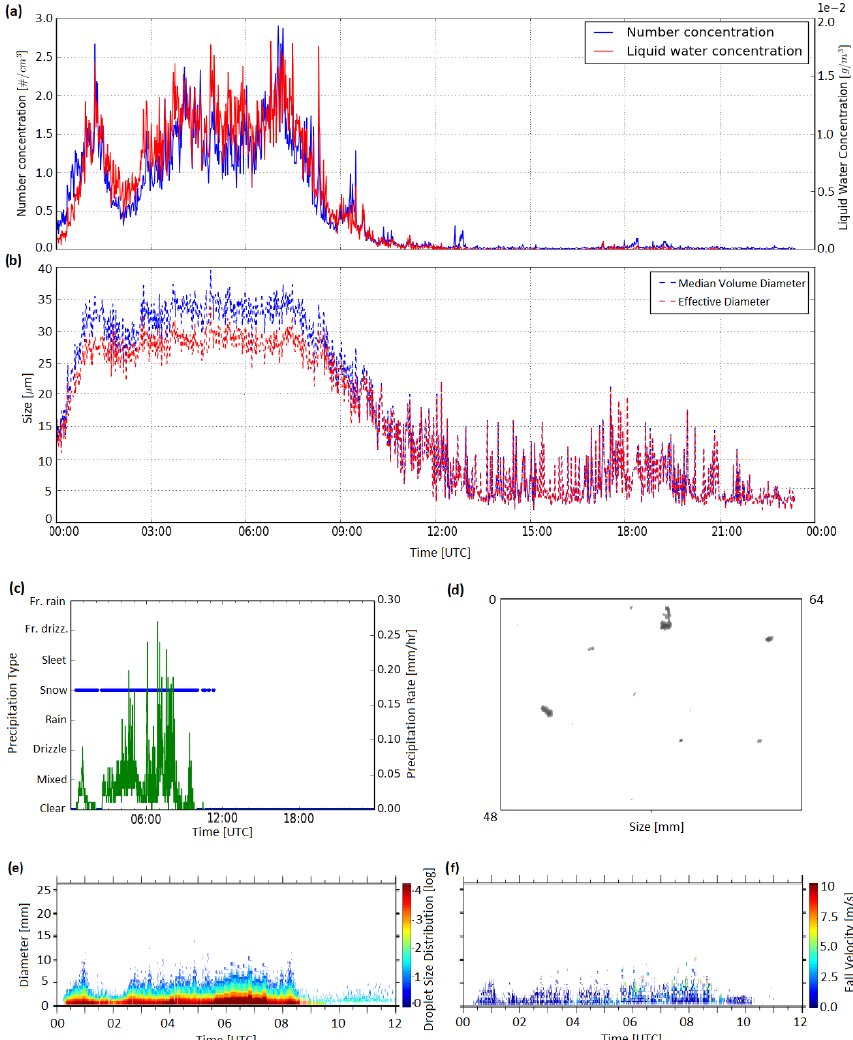
Figure 8. In situ observations of microphysical properties of precipitation during the 23 November 2018 blizzard at Iqaluit: (a) FMD number (blue) and liquid water (red) concentration, (b) FMD median volume diameter (blue) and effective diameter (red) particle size, (c) PWD52 precipitation rate (green) and type (blue), PIP observations of (d) snowflakes (photo) taken at 08:37UTC, (e) DSD, and (f) particle fall velocity during the